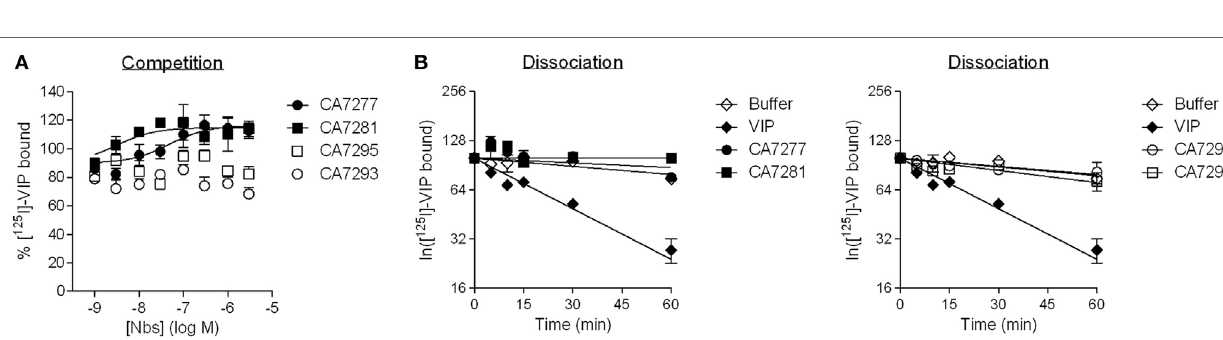
FigUre 3 | Vasoactive intestinal polypeptide (VIP) binding experiments. (a) Competition binding on CHO cells expressing VPAC1 using [ 125 I]-VIP as tracer in presence of increasing concentrations of CA7277 (filled circles), CA7281 (filled squares), CA7293 (open circles), or CA7295 (open squares). (B) Kinetic studies of the dissociation of [ 125 I]-VIP from CHO cells expressing VPAC1 (after 30 min of association at 23°C), following addition of 1 µM VIP (filled diamonds), 3 µM CA7277 (filled circles), CA7281 (filled squares), CA7293 (open circles), CA7295 (open squares), or buffer (open diamonds). The results are the means ± SEM of three independent experiments performed in duplicate.